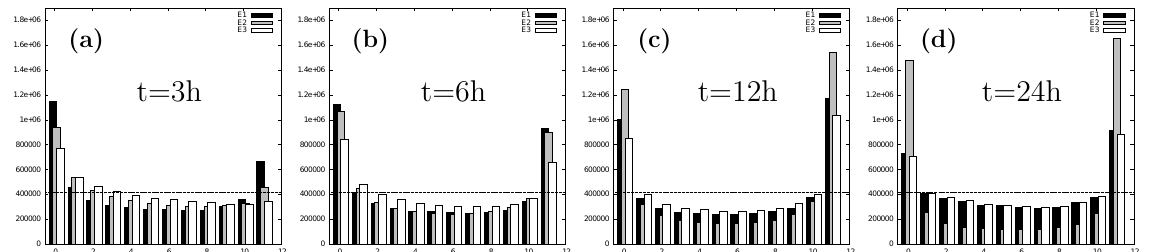
Fig. 3. Rank histograms for the 925-hPa wind speed from 15 October 2008 to 1 November 2008 at a forecast range of (a) 3, (b) 6, (c) 12 and (d) 24h. E1 (black), E2 (gray) and E3